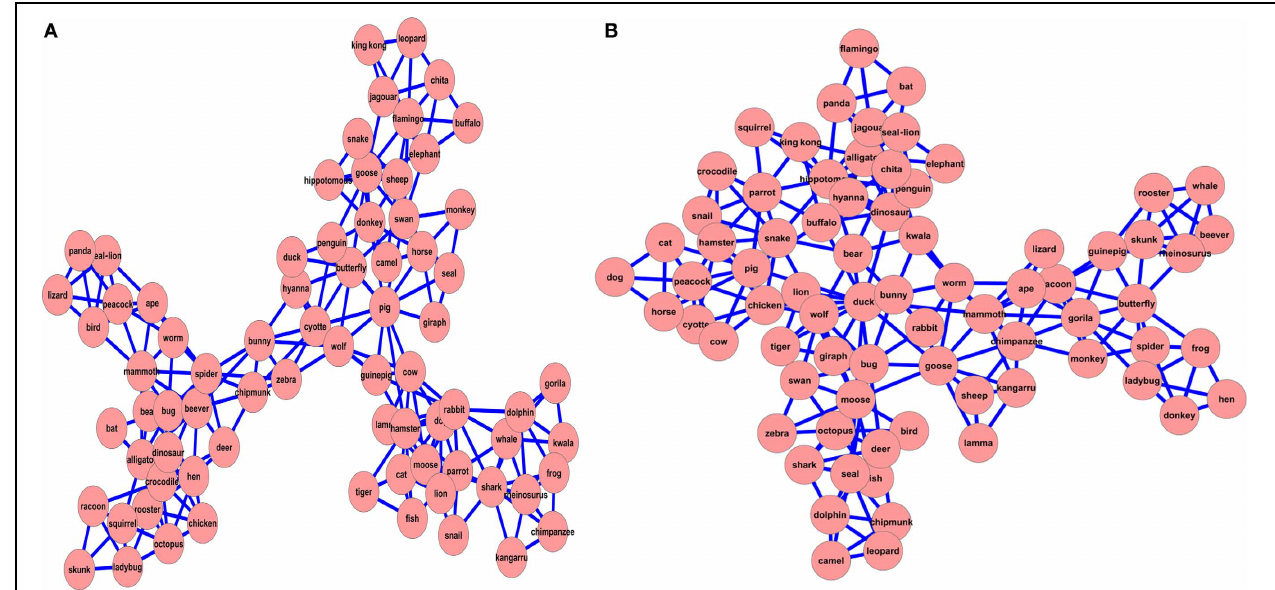
FIGURE 2 | 2D visualization of word-match correlation networks for the NH group (A) and the CI group (B).